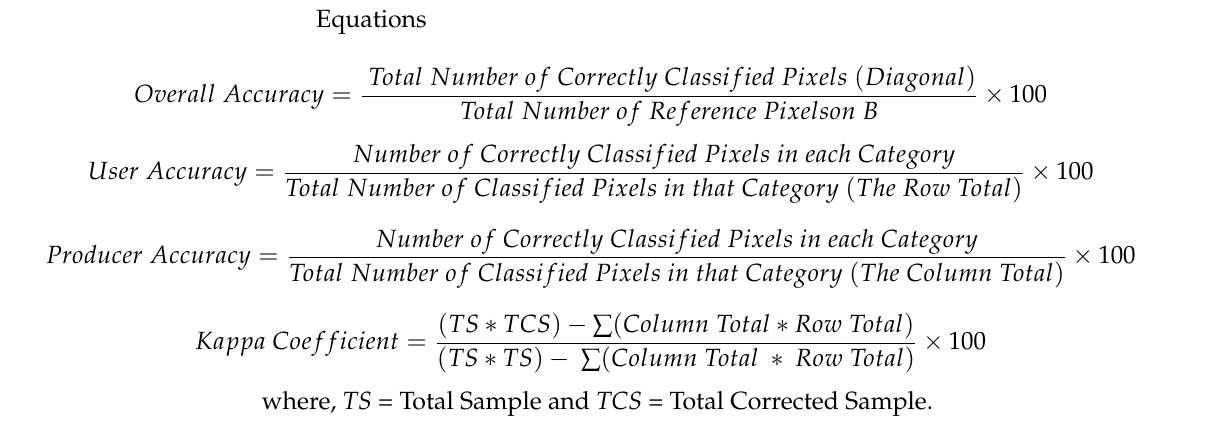
Table A2. Accuracy assessment table of 1989 LU/LC classification.